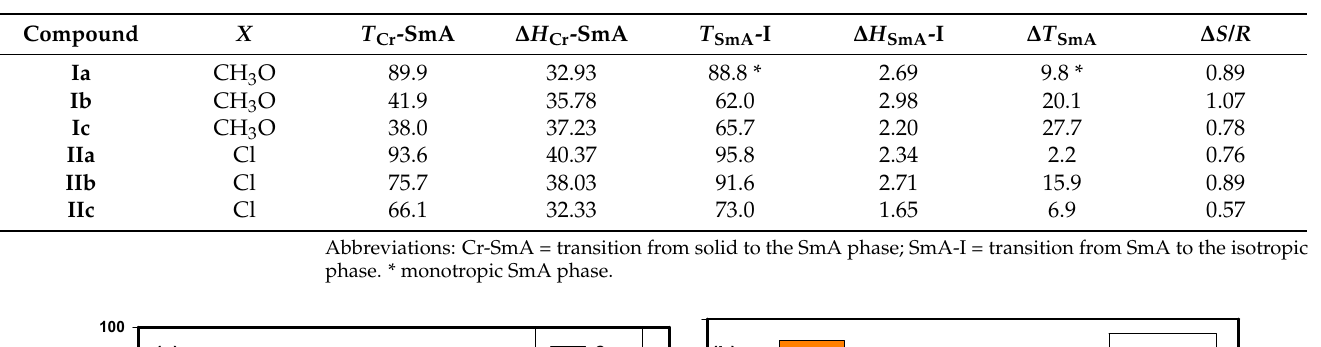
Table 1. Transition temperature ( ◦ C), enthalpy (kJ/mol), normalized entropy of transition, and mesophase range of groups Ia-c and IIa-c .